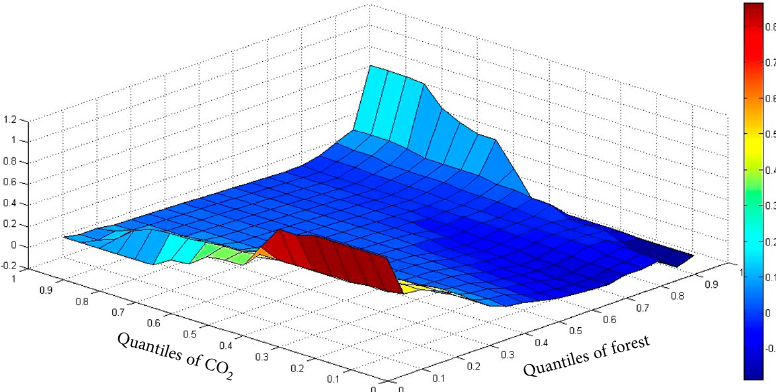
Figure 3. Quantile on quantile regression estimation for